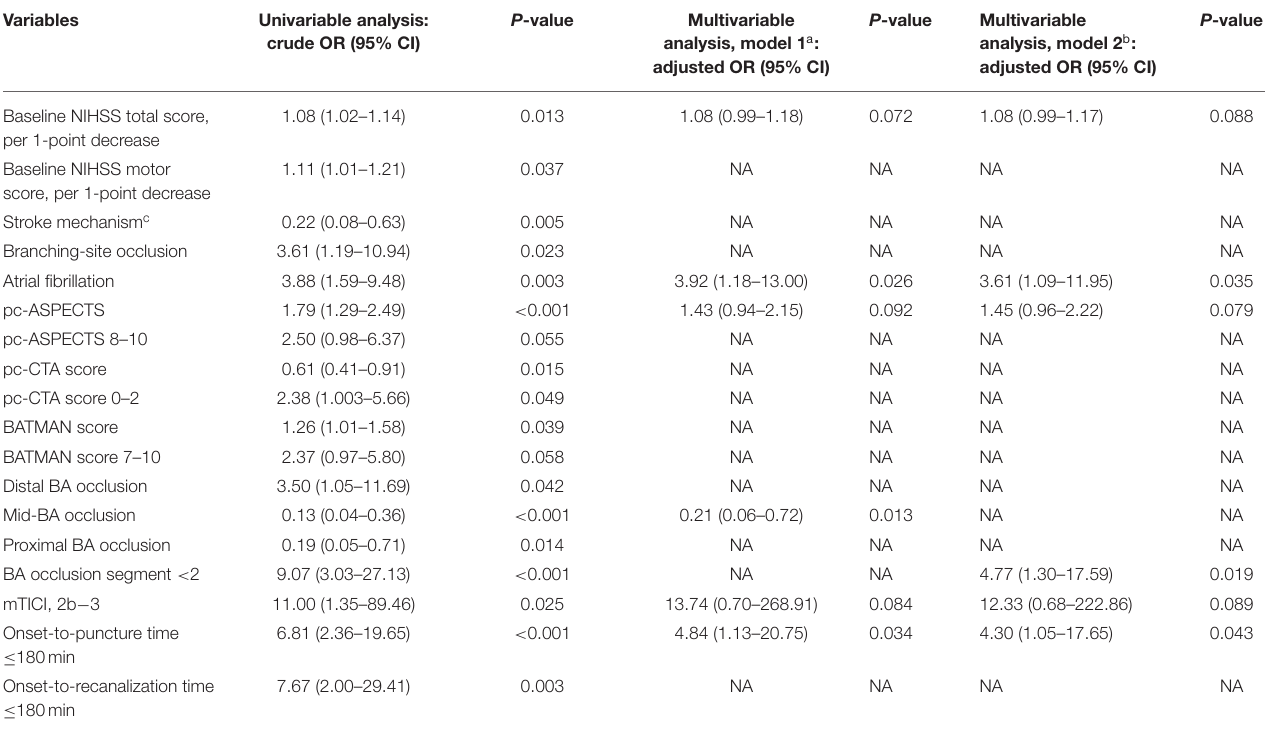
BA,basilarartery;BATMANscore,basilararteryoncomputedtomographyangiographyscore;CI,confidenceinterval;mTICI,modifiedtreatmentincerebralischemia;NA,notapplicable; NIHSS, National Institutes of Health Stroke Scale; pc-ASPECTS, posterior circulation Acute StrokePrognosis Early CT Score; pc-CTA score, posterior circulation computed tomography angiography score; OR, odds ratio. a Adjusted for the baseline NIHSS total score, stroke mechanism, branching-site occlusion, atrial fibrillation, pc-ASPECTS, pc-CTA score, distal